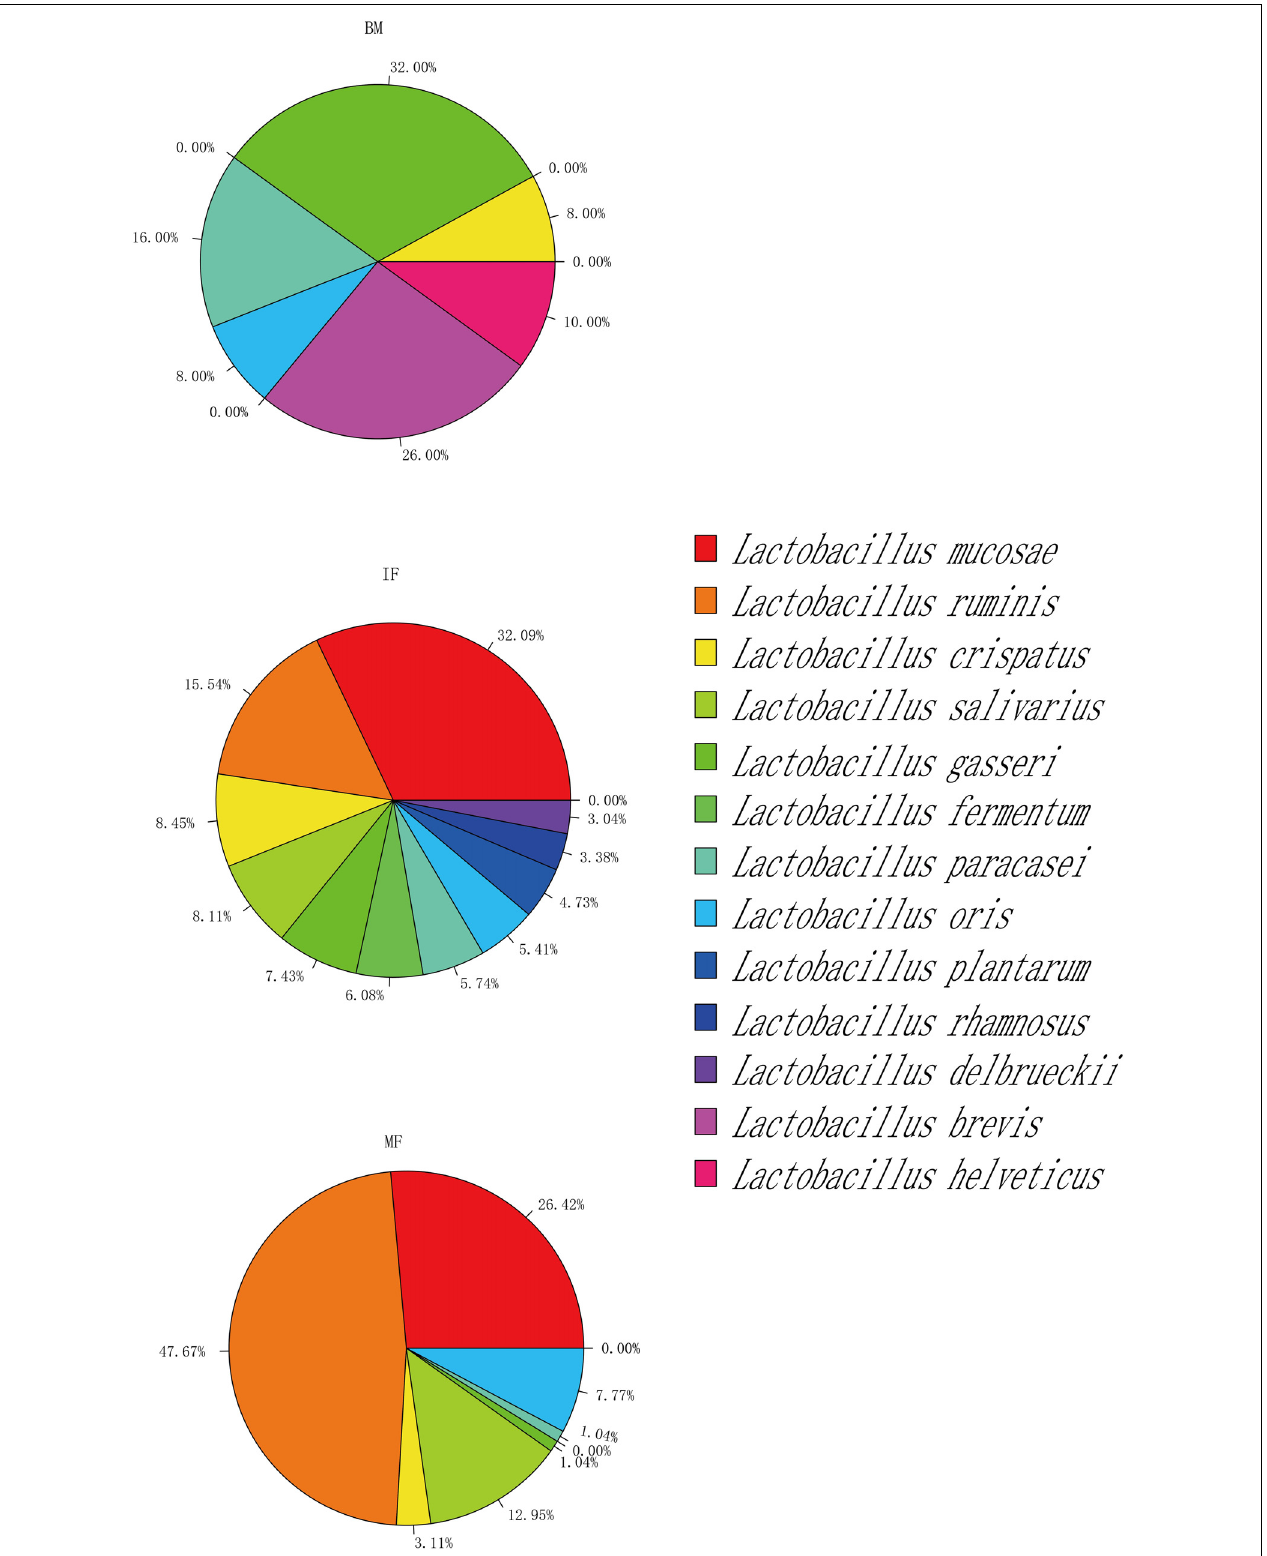
FIGURE 6 | Taxonomy of selected Lactobacillus strains isolated from maternal feces (MF, n = 25), breast milk (BM, n = 25), and infant feces (IF, n = 25).